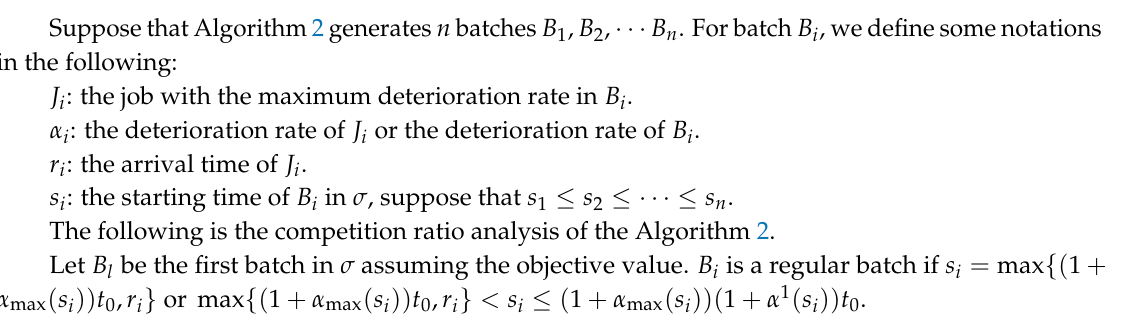
Figure 3. Optimal offline schedule for Instance I 2